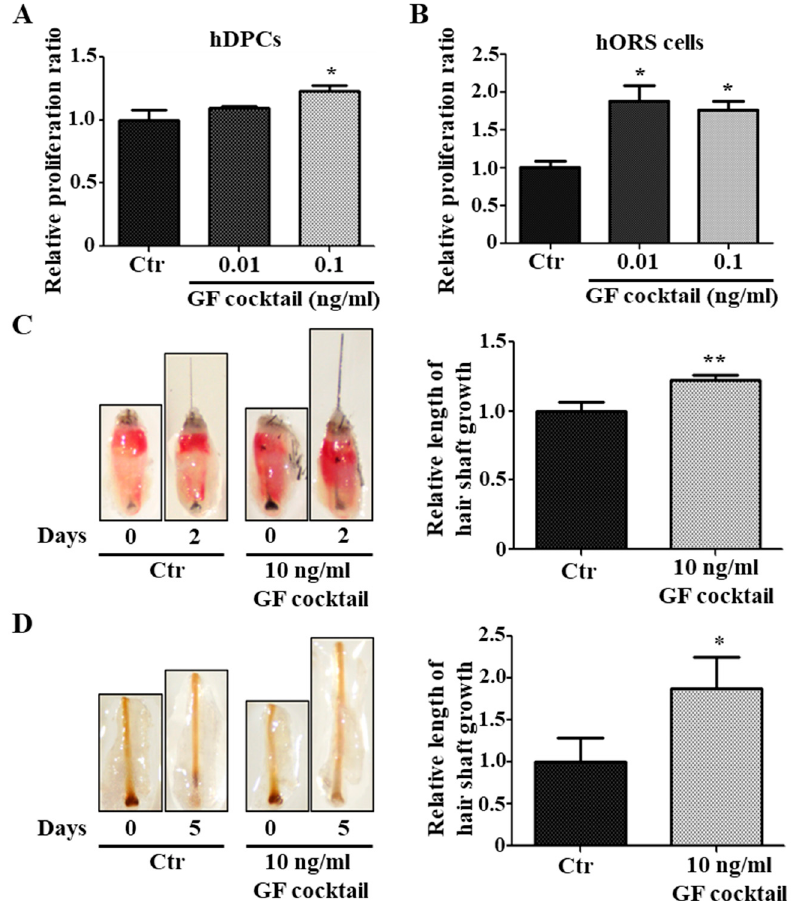
Figure 6. GF cocktail promoted hair growth. ( A , B ) GF cocktail increased the proliferation of hDPCs ( A ) and hORS cells ( B ). ( C ) GF cocktail promoted the growth of mice vibrissae hair shaft at a concentration of 10 ng / mL. ( D ) GF cocktail promoted the growth of the length of a pig skin hair shaft at a concentration of 10 ng / mL. GF cocktail; complex of upregulated growth factors in Rab27b siRNA-treated in hDPCs. * p < 0.05, ** p < 0.01 using ANOVA followed with Tukey’s post hoc test or Student’s t test. Three independent experiments were conducted. All error bars indicate S.E.M.